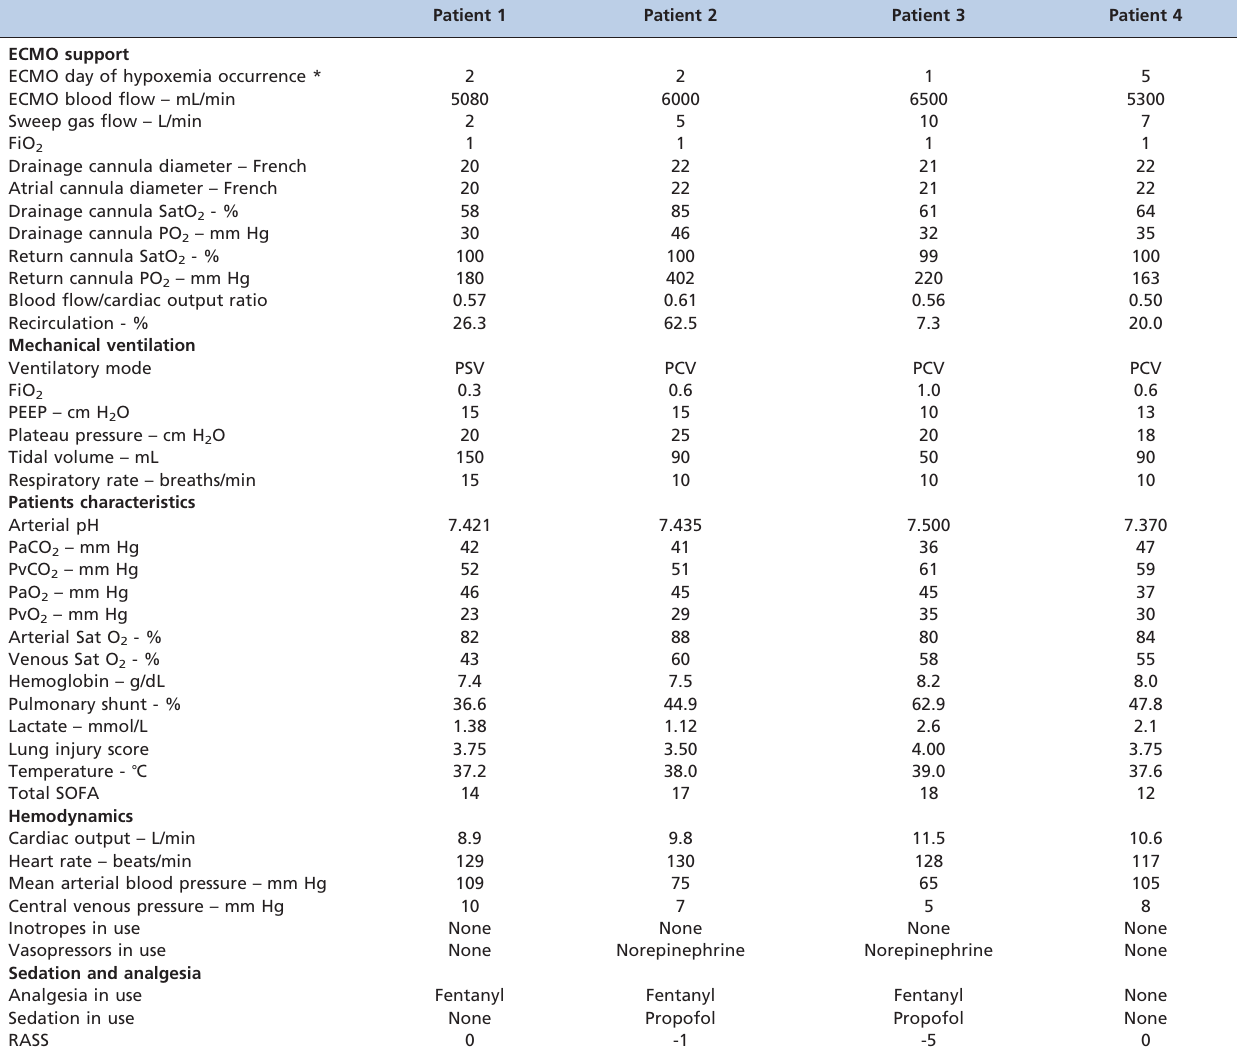
Table 2 - Clinical characteristics at the time of severe hypoxemia